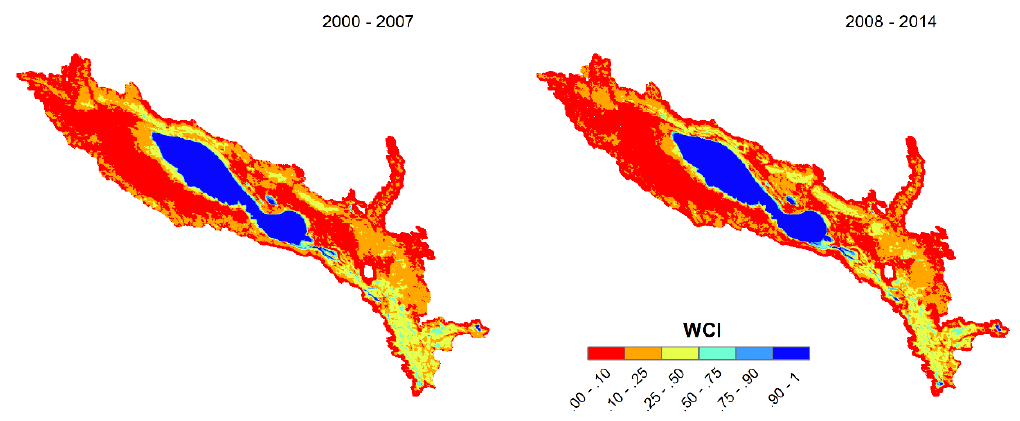
Figure 5. Comparison of the Water Covered Index (WCI) of Tonle Sap before and after 2008.